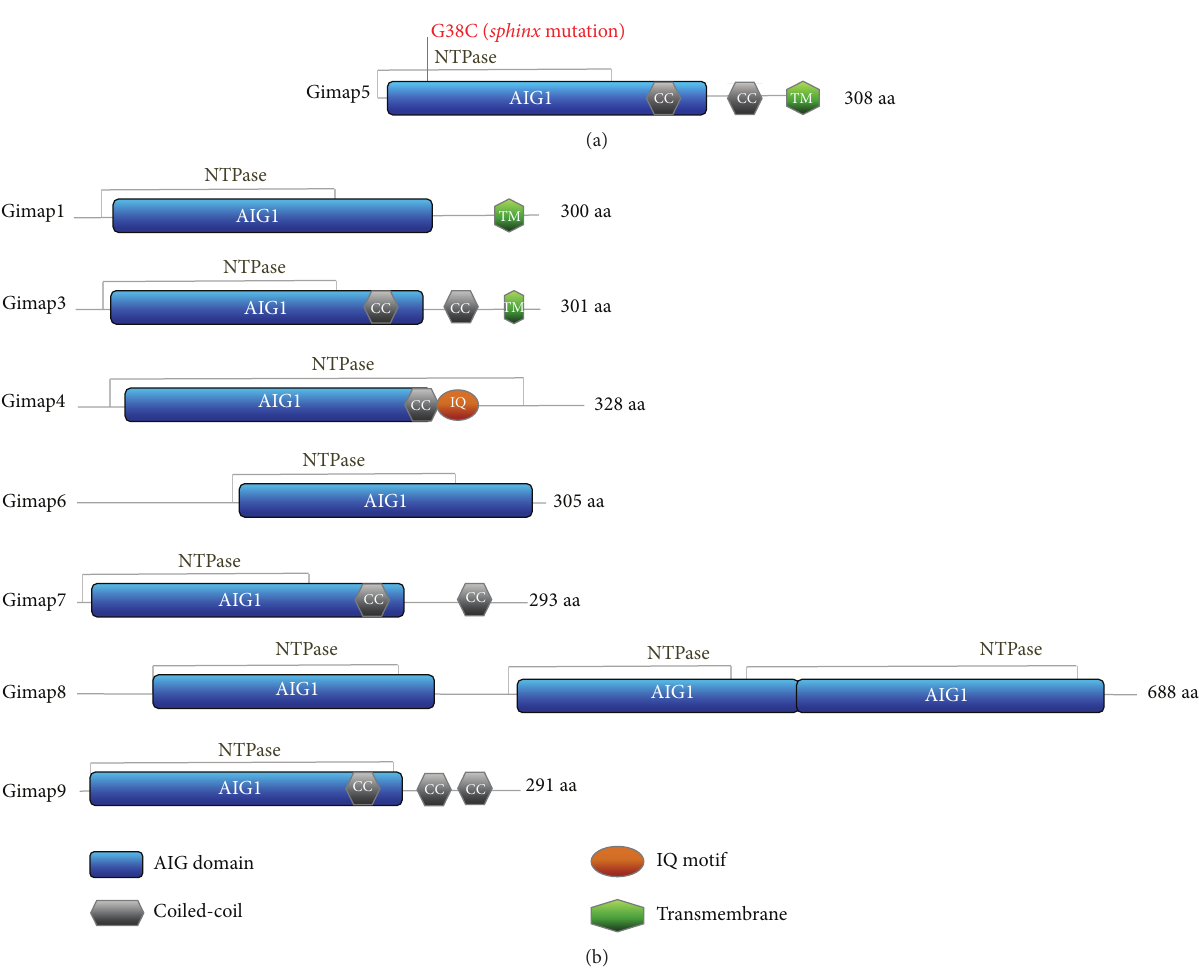
Figure 1: Predicted structural domains within mouse Gimap5. (a) Mouse Gimap5 is a 308-amino acid protein that contains an AIG1 domain (residues 24–227), a P-loop NTPase domain (residues 1–168), two coiled-coil domains (residues 187–221 and 239–265), and a transmembrane domain (residues 284–304). The G → C missense mutation in sphinx mice at residue 38 is indicated. (b) Schematic overview of the domain features present in the different Gimap family